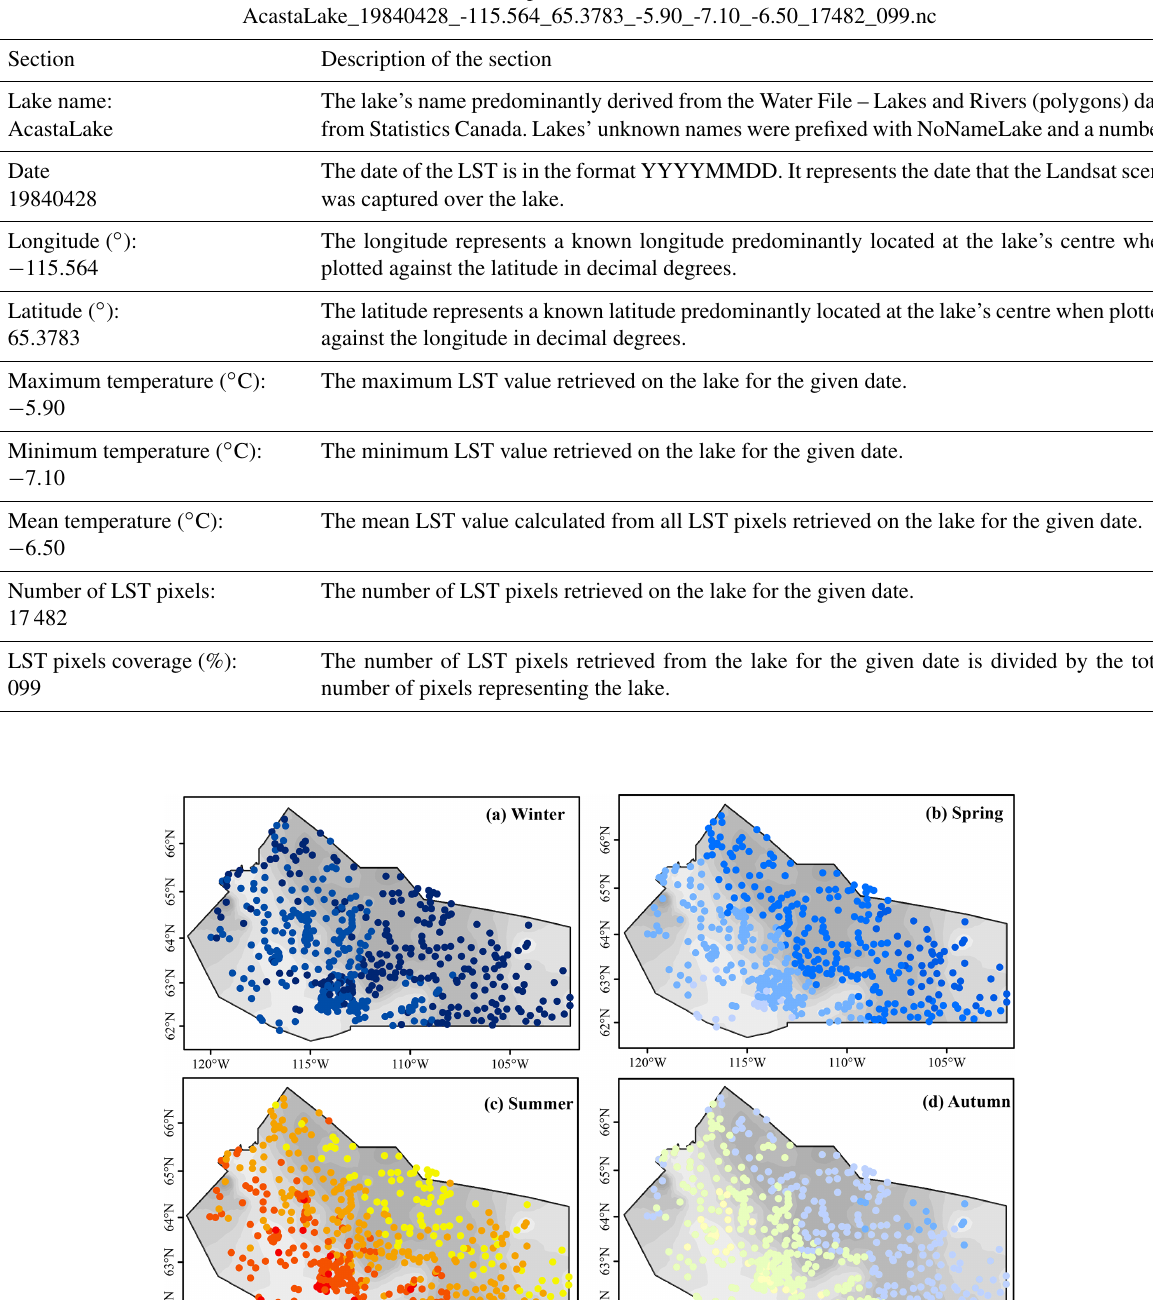
Table 3. Sections of North Slave LST dataset’s NetCDF filename and description.